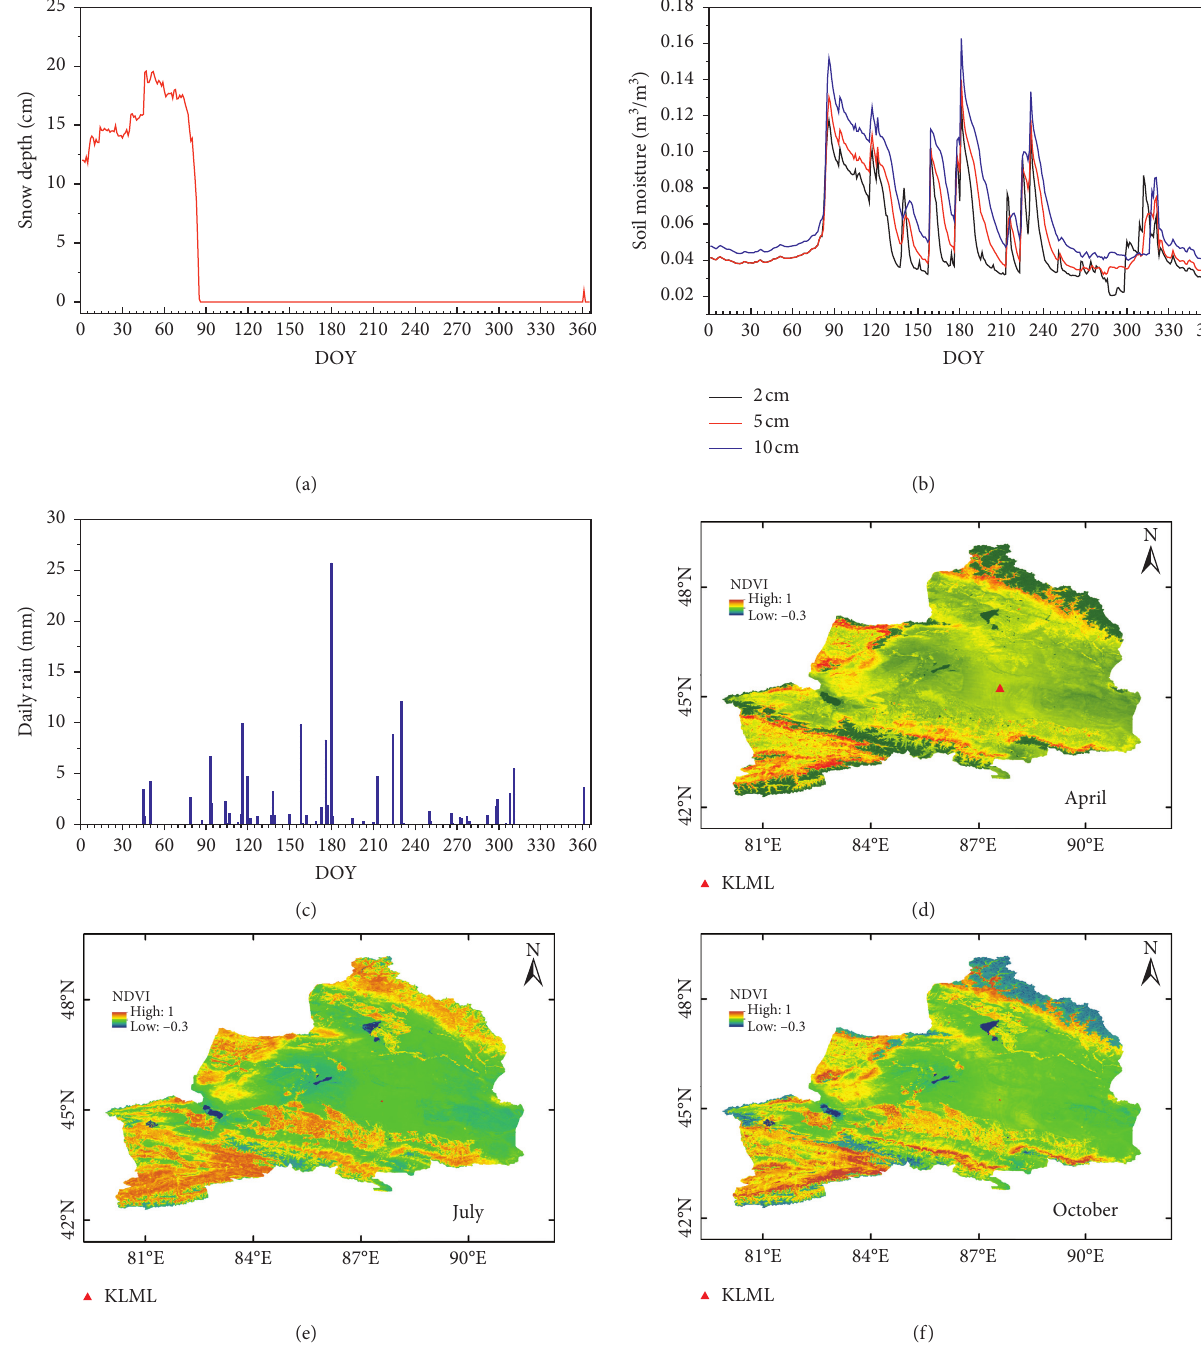
Figure 6: Monitoring of the change of the underlying surface of the Gurbant¨ungg¨ut Desert in spring. (a) Daily average snow depth. (b) Shallow soil moisture. (c) Daily precipitation. (d–f) Month average